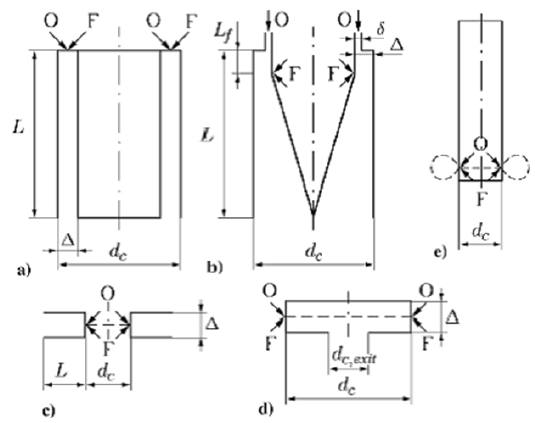
Fig. 7. Geometries of detonation chambers tested by Bykovskii et al. a) annular chamber, b) partially annular with inner cone, c) open space